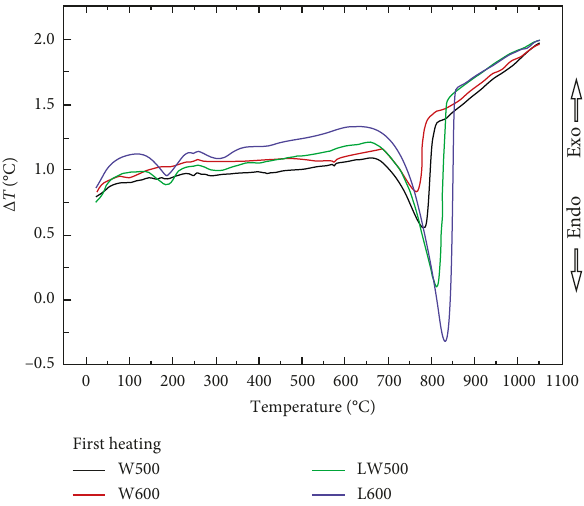
Figure 6: Comparison of DTA curves of the first